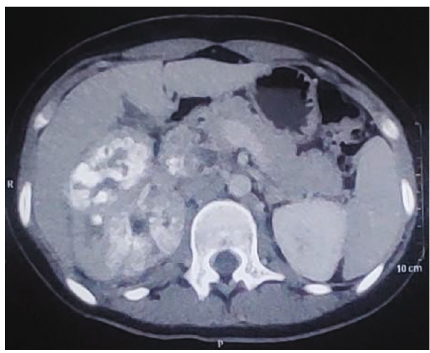
Figure 1: Axial CT scan showing right renal calci fi cations with involvement of IVC.